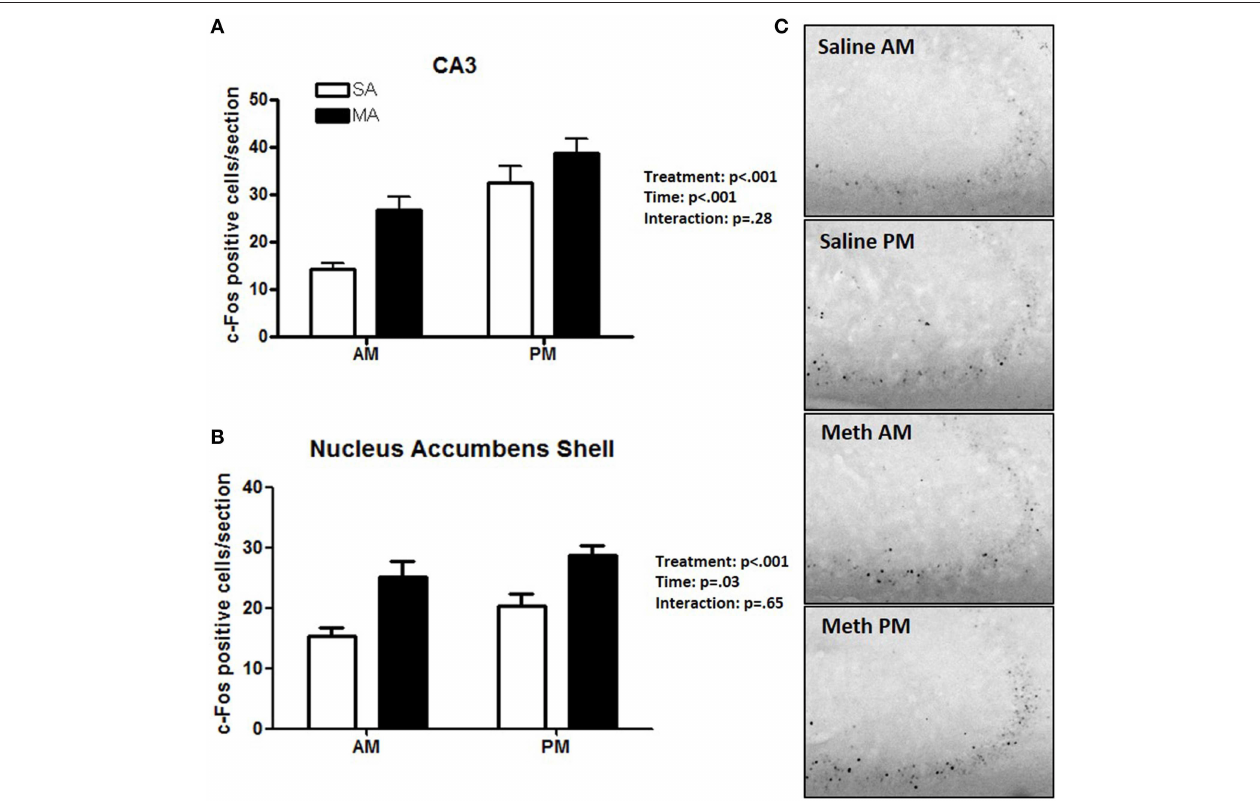
FIGURE 4 | Brain areas that showed effects of treatment and time. In the CA3 (A) and NACs (B) , MA and time affected the number of c-Fos positive cells and no MA × time interaction was seen. Representative images for neuronal activation in the CA3 following saline or MA exposure in the day and night are shown in (C) . n = 10 mice/treatment/time